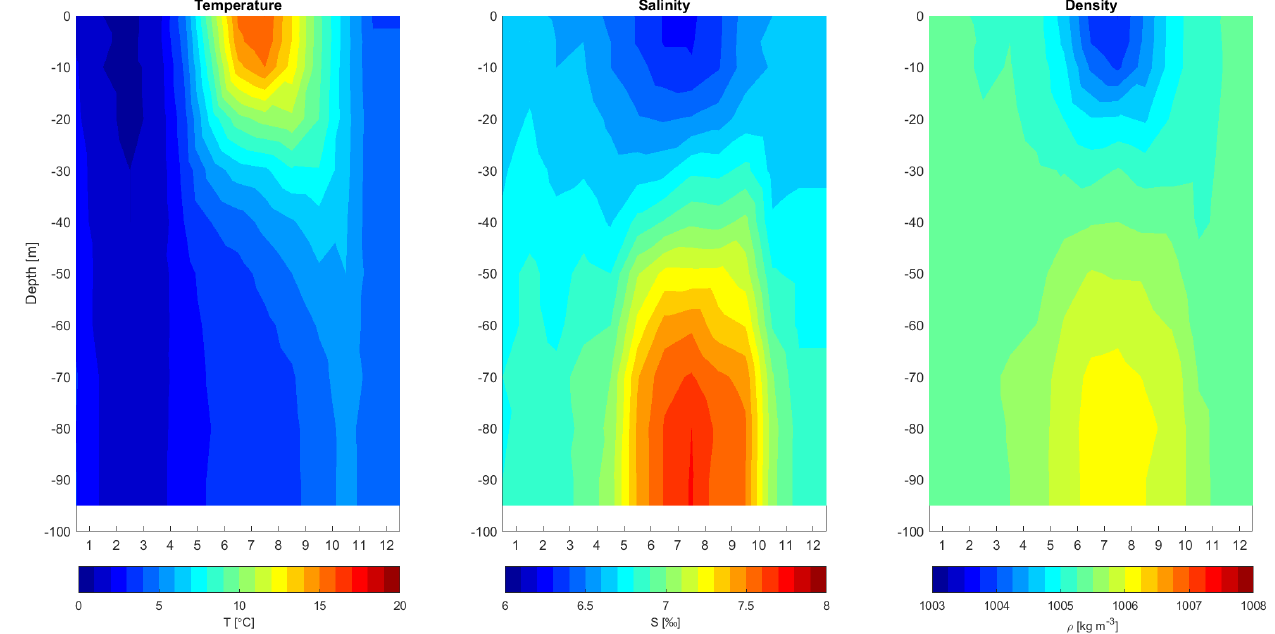
Figure 6. Monthly median seawater temperature, salinity and density in Utö during